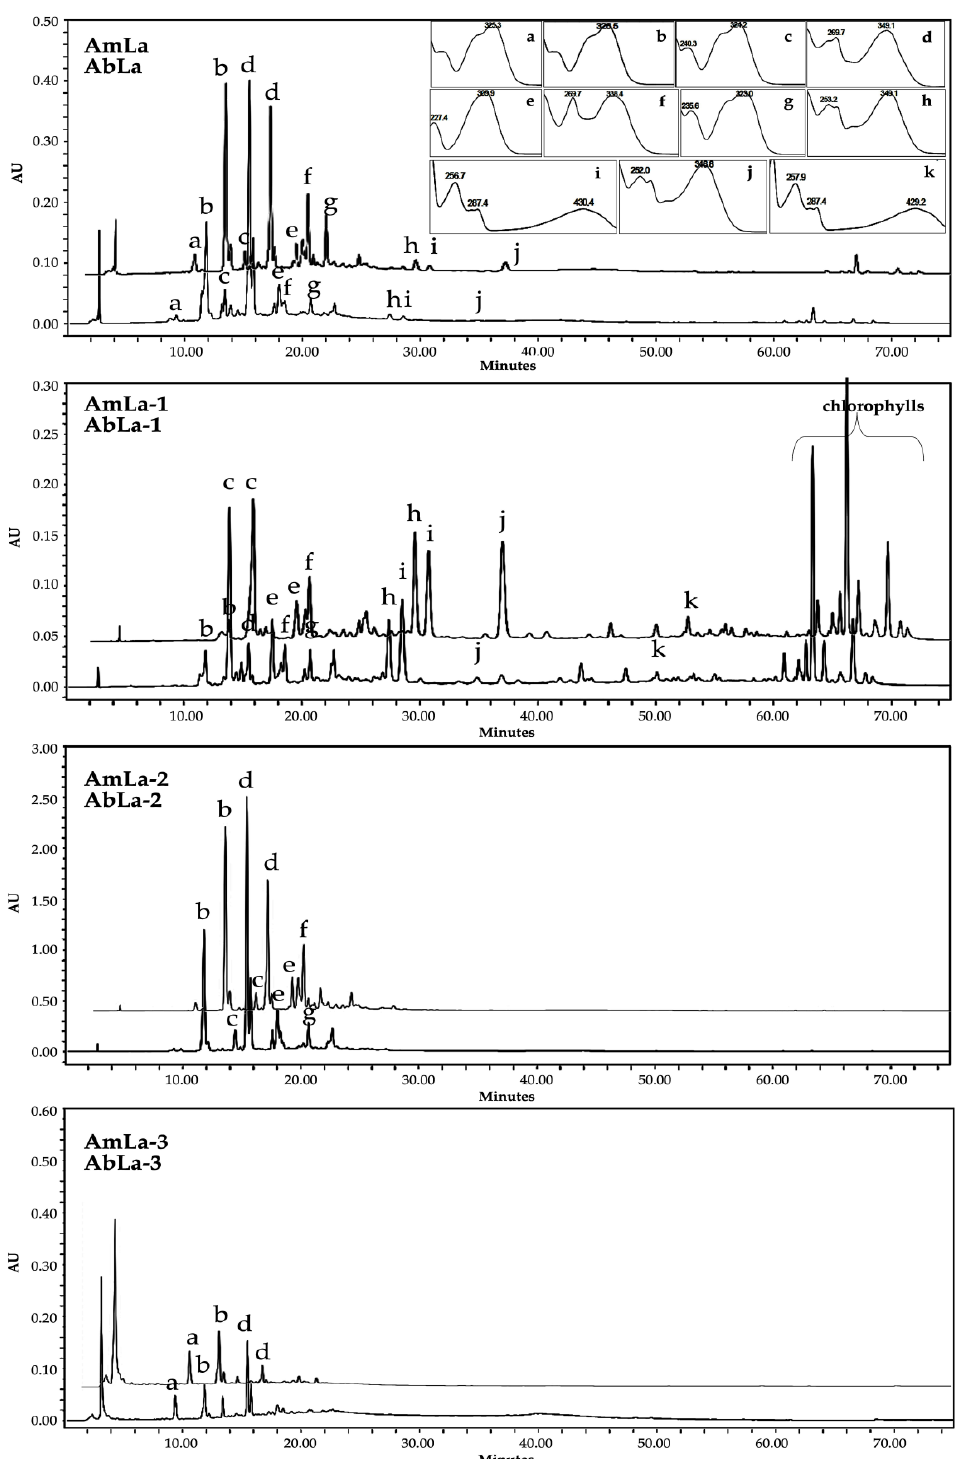
Figure 1. Comparative HPLC-UV/DAD chromatographic profiles of marker secondary metabolites of A. bento-rainhae and A. macrocarpus leaf crude extracts and their subsequent L-L partitions. Abbre- viations: AbLa: A. bento-rainhae leaf first collection, AmLa: A. macrocarpus leaf first collection, ( − 1): ethyl ether fractions, ( − 2): ethyl acetate fractions, and ( − 3): aqueous